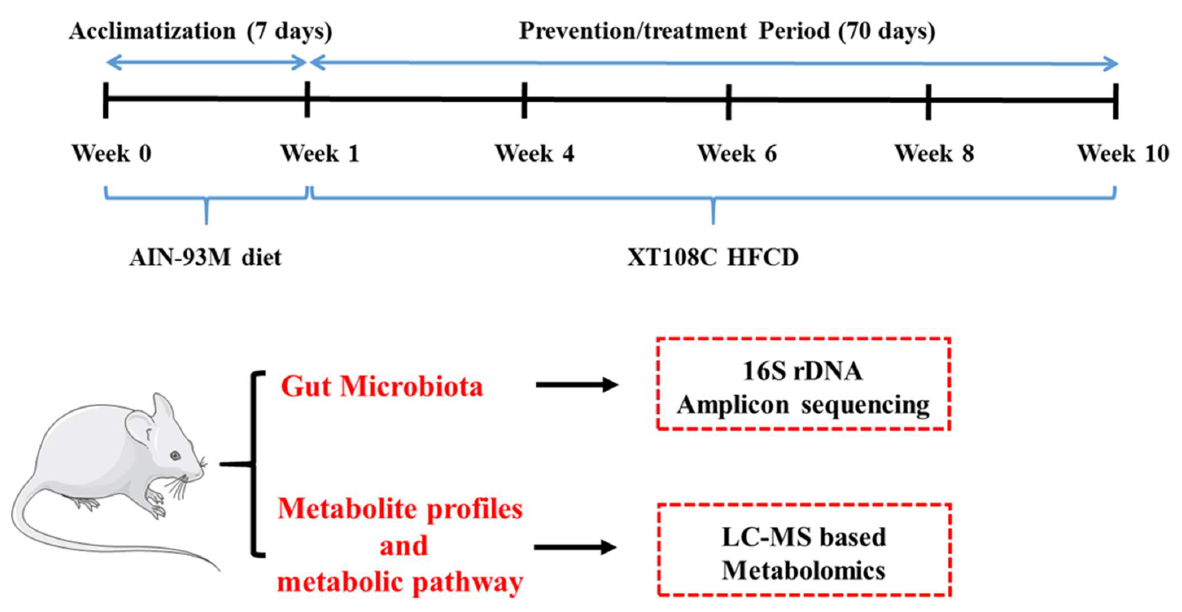
Figure 1. Animal study design. Normal control group (NCG, fed with AIN-93M diet), HFCD group (FG, fed with XT108C diet), HB HFCD group (HBG, fed with XT108C mixed HB diet), HB-1 HFCD group (HB-1, fed with XT108C mixed HB-1 diet), HB-2 HFCD group (HB-2, fed with XT108C mixed HB-2 diet), and HB-3 HFCD group (HB-3, fed with XT108C mixed HB-3 diet).